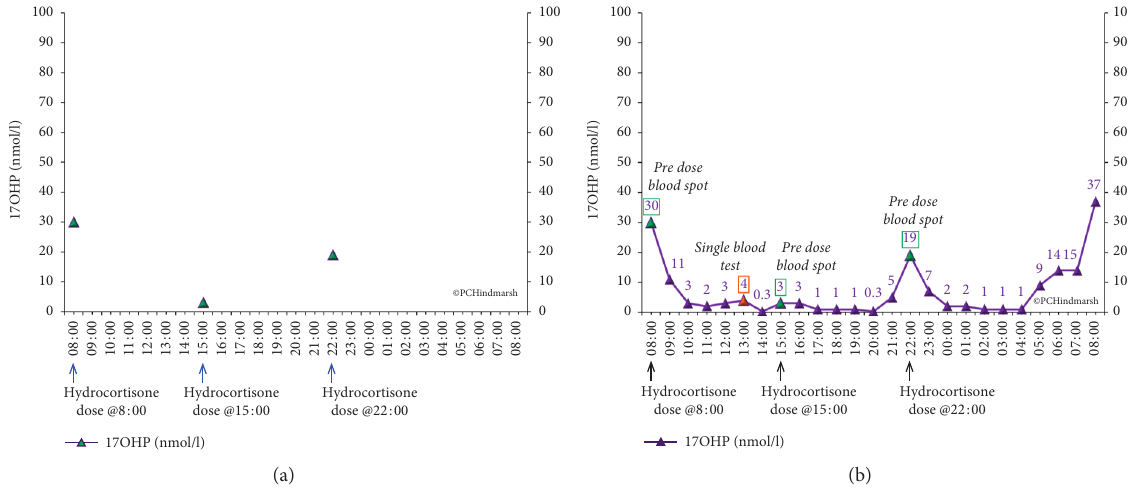
Figure 8: Full plasma 17 hydroxyprogesterone concentration profile (purple line and triangles) from the patient described in Figure 4 to illustrate the effect of sampling interval on the data obtained. Samples as (a) three time point spot samples (green triangles) before dosing with hydrocortisone and (b) how a single (orange triangle) or three (green triangles) time point samples do not reflect what is taking place over the 24-hour period. Blood samples are taken hourly to construct the profile. Reproduced from Congenital Adrenal Hyperplasia: A Comprehensive Guide, Hindmarsh P and Geertsma K Elsevier, New York